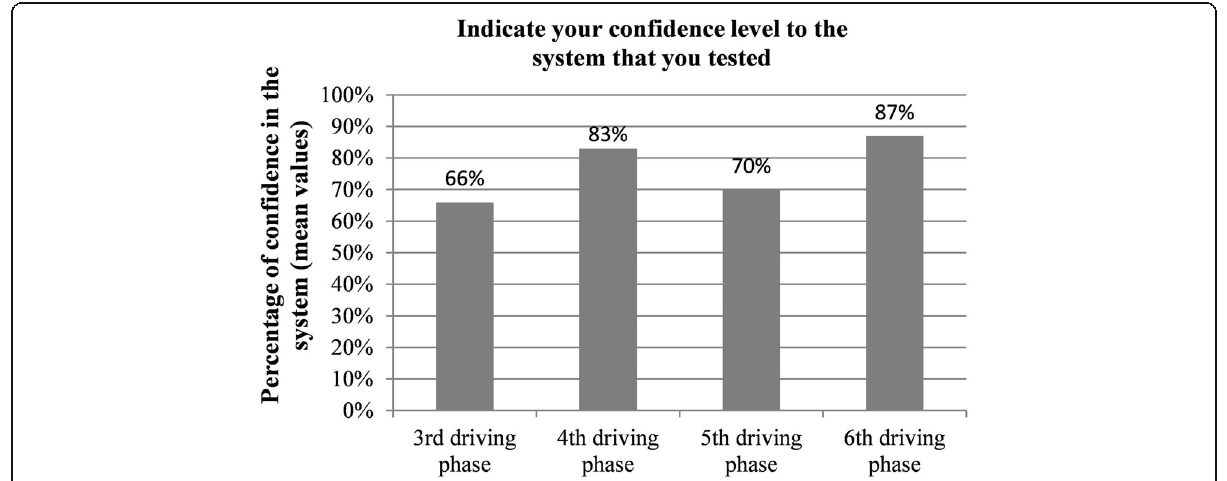
Fig. 6 Mean values of the percentage of confidence levels on the CAS, as indicated by the users for the four driving